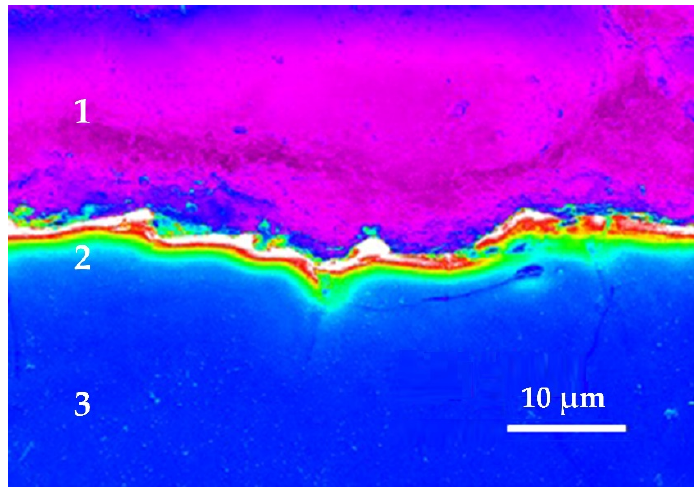
Figure 4. White layer obtained by electric discharge machining 99.9% pure chromium by a brass-wire electrode in a water medium: ( 1 ) is an epoxy resin that contains a sample for SEM analysis, ( 2 ) is a white layer of thermal exposure, a saturated component wire electrode—copper and zinc, ( 3 ) is a cut of the machined part made of chromium.